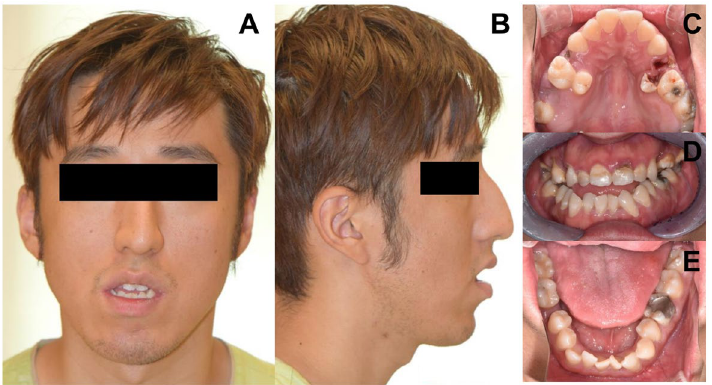
Figure 1. Facial and dental characteristics of the patient. The face was long and narrow and showed signs of third nerve palsy, grimacing smile, pinched and hump nose, maxillary retrognathia compared to the mandible, and skeletal Class III malocclusion without microencephaly ( A , B ). Dental examination revealed V-shaped and high arched palate, crowding of the teeth, anterior open bite, many dental caries, teeth fractures and ectopic eruptions, and narrow maxillary width compared to the mandible ( C – E